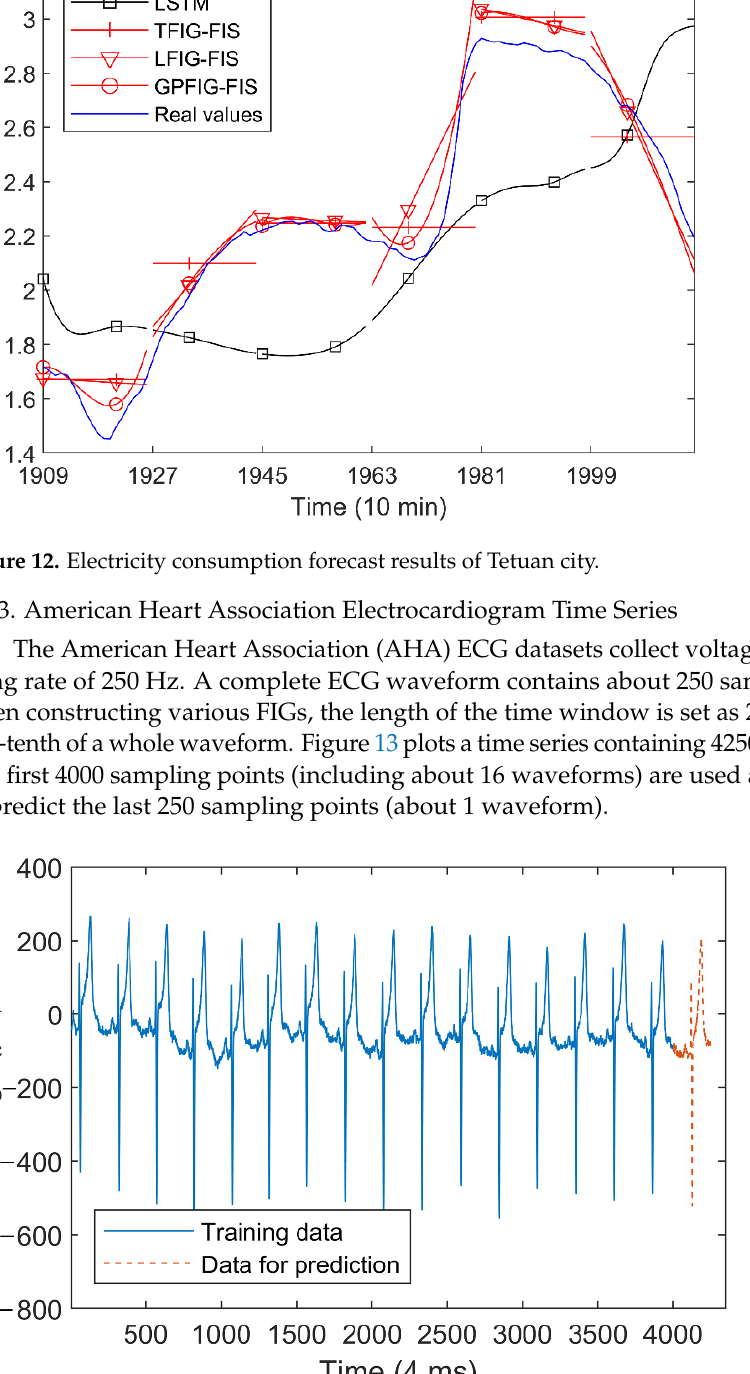
Figure 13. Electrocardiogram time series. Set the number of the FIS input q = 10 for each prediction method. Due to the complexity of the ECG waveform, the polynomial order of the PFIG is set as four. Table 3 shows the RMSE and SMAPE indexes of the various prediction